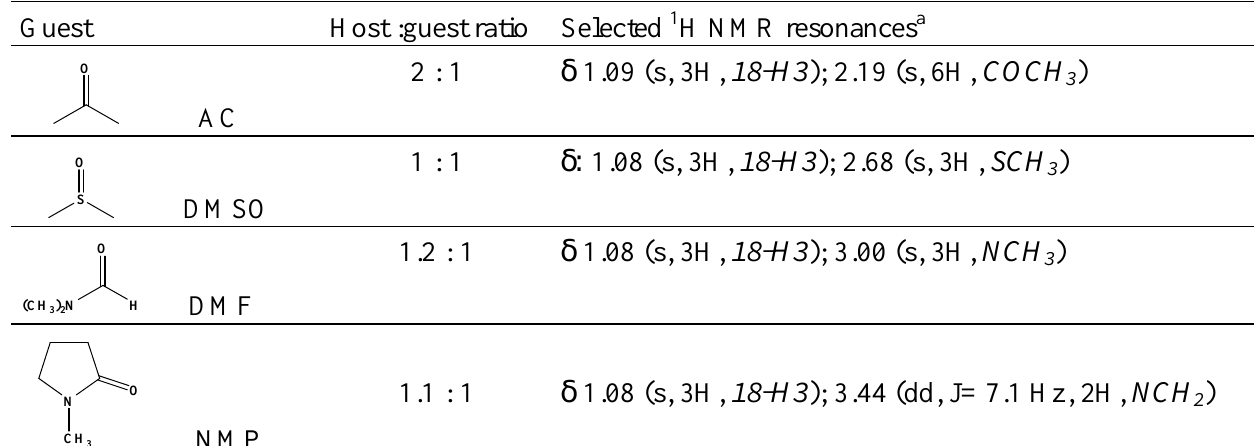
Table 1. Guests, inclusion ratio and selected resonances for inclusion in dehydrocholic acid 1